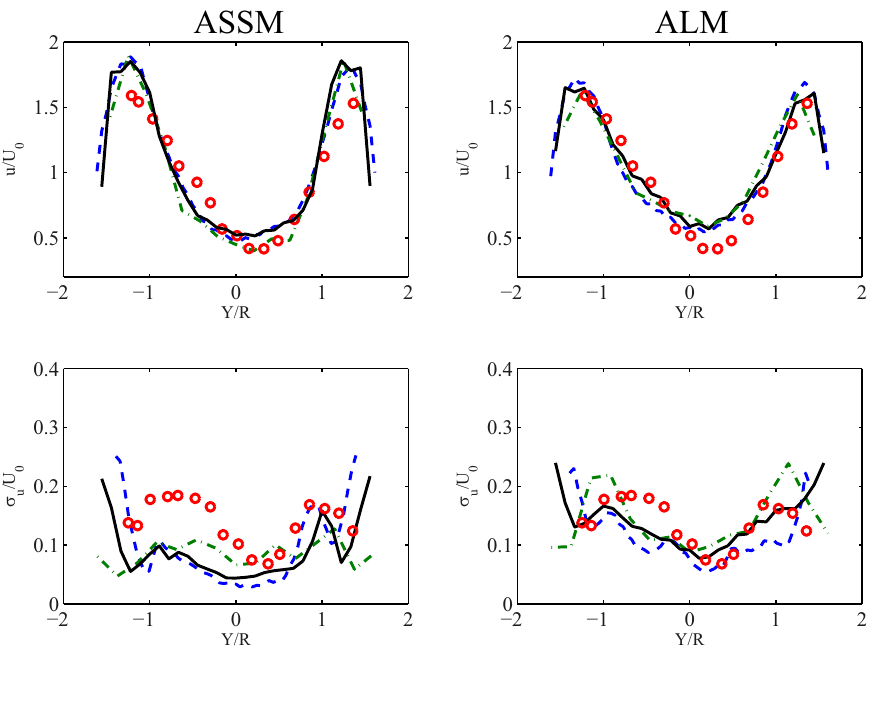
Figure 16. The effect of the grid resolution on the spanwise profiles of the normalized mean streamwise velocity and mean streamwise turbulence intensity (resolved part) for the ASSM ( left ) and the ALM ( right ) simulations at x/R = 5 . 0 . Water channel measurements (red circles), 60 × 400 × 80 (dashed blue line), 30 × 240 × 80 (solid black line) and 15 × 120 × 80 (dash-dotted green